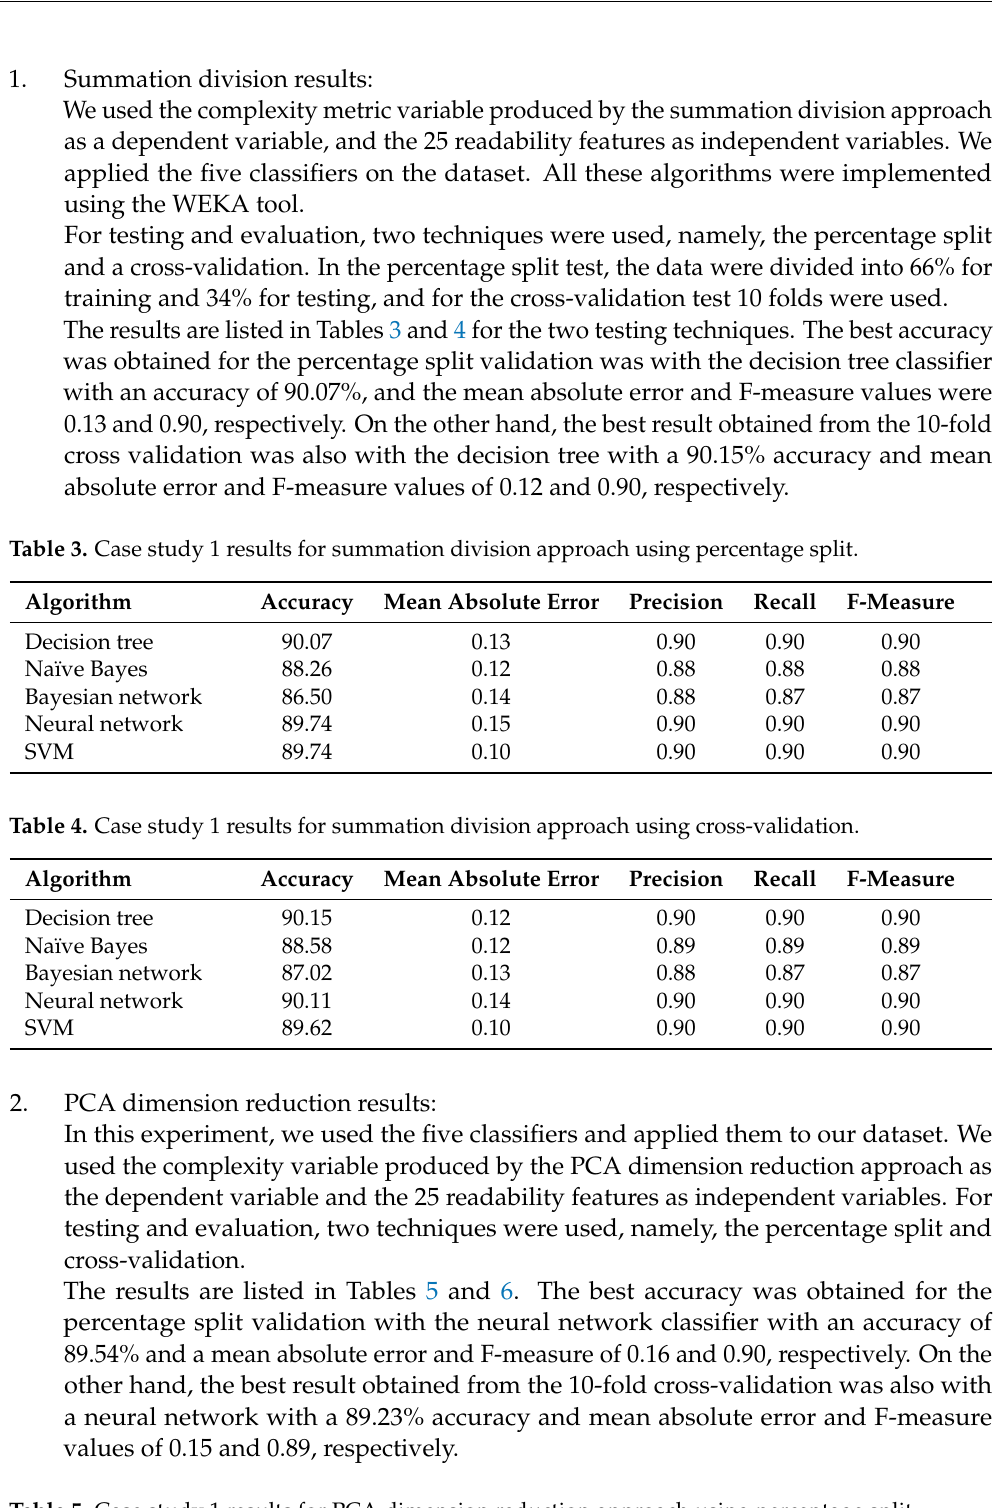
Table 5. Case study 1 results for PCA dimension reduction approach using percentage split.